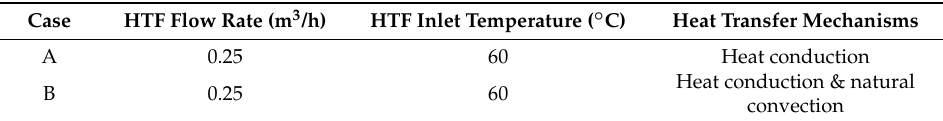
Table 5. Numerical settings for the two cases.